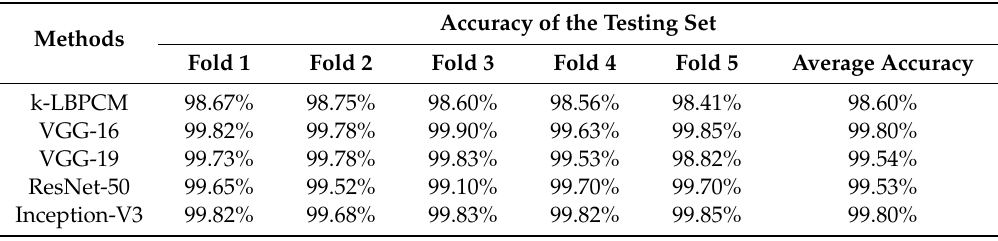
Table 5. Classification accuracies of the test set among di ff erent methods in the “bccr-segset” dataset with the batch size of 64 and dropout